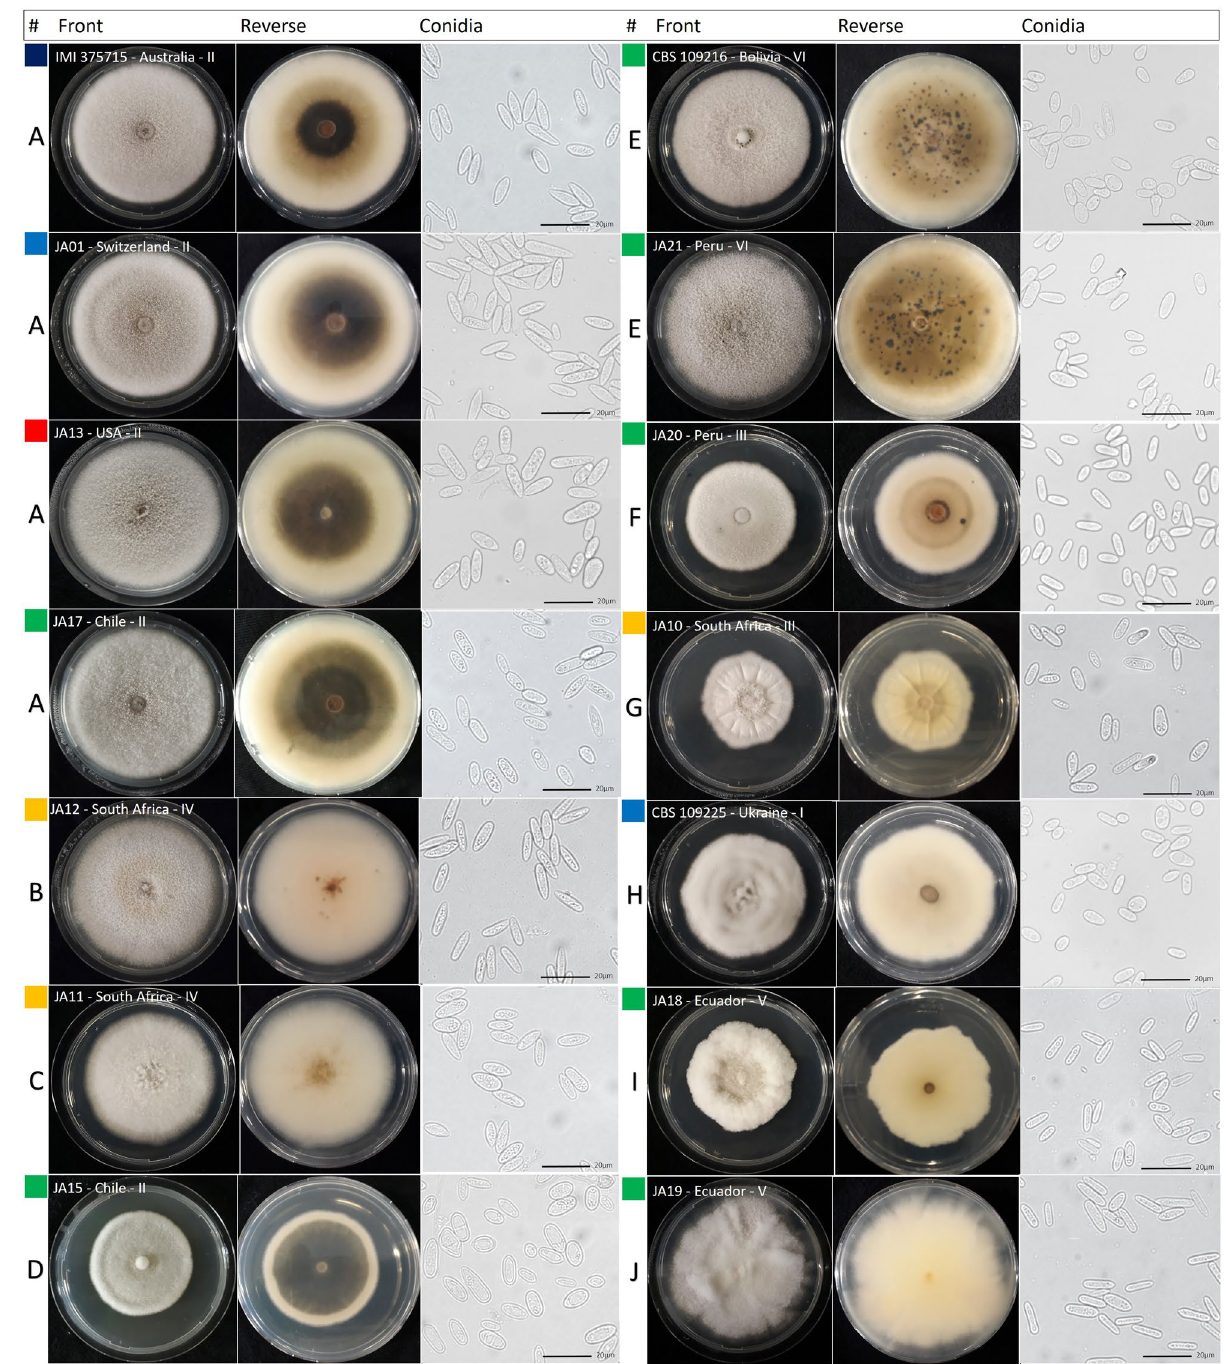
Figure 2. Colletotrichum lupini morphology. Capital letters (A–J) indicate the different morphology types based on conidia shape and size and colony growth rate and morphology (see Table 2). Strain codes are followed by country of origin and roman numbers (I–VI) indicate genetic groups. Plates show the front and reverse of 14 day old colonies on PDA. Scale bars indicate 20 µm. Colors indicate strain origin: blue = Europe, green = South America, red = North America, orange = Southern Africa, dark blue =